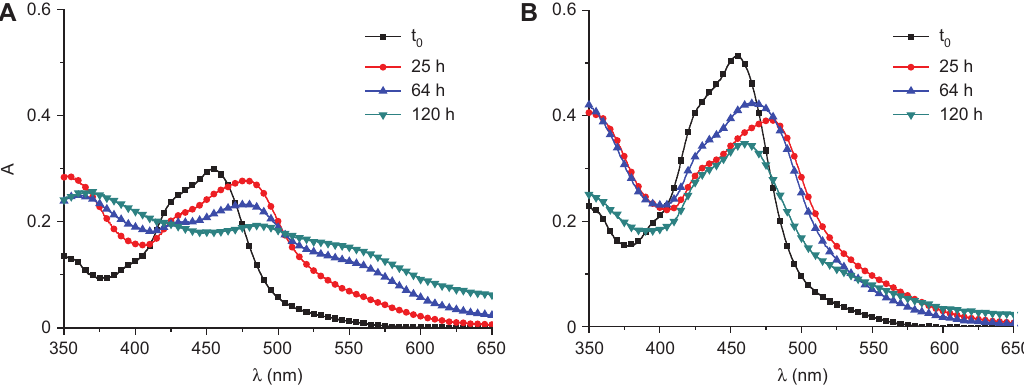
Figure 3 Absorbance change by irradiation of a 5 × 10 -3 m solution of 1a in DMF in the presence of 0.2 m triethanolamine (TEOA): (A) in the absence; and (B) in the presence of 2 (5 × 10 -3 m ). Notice that the photolyzed solution was diluted by a factor ten.